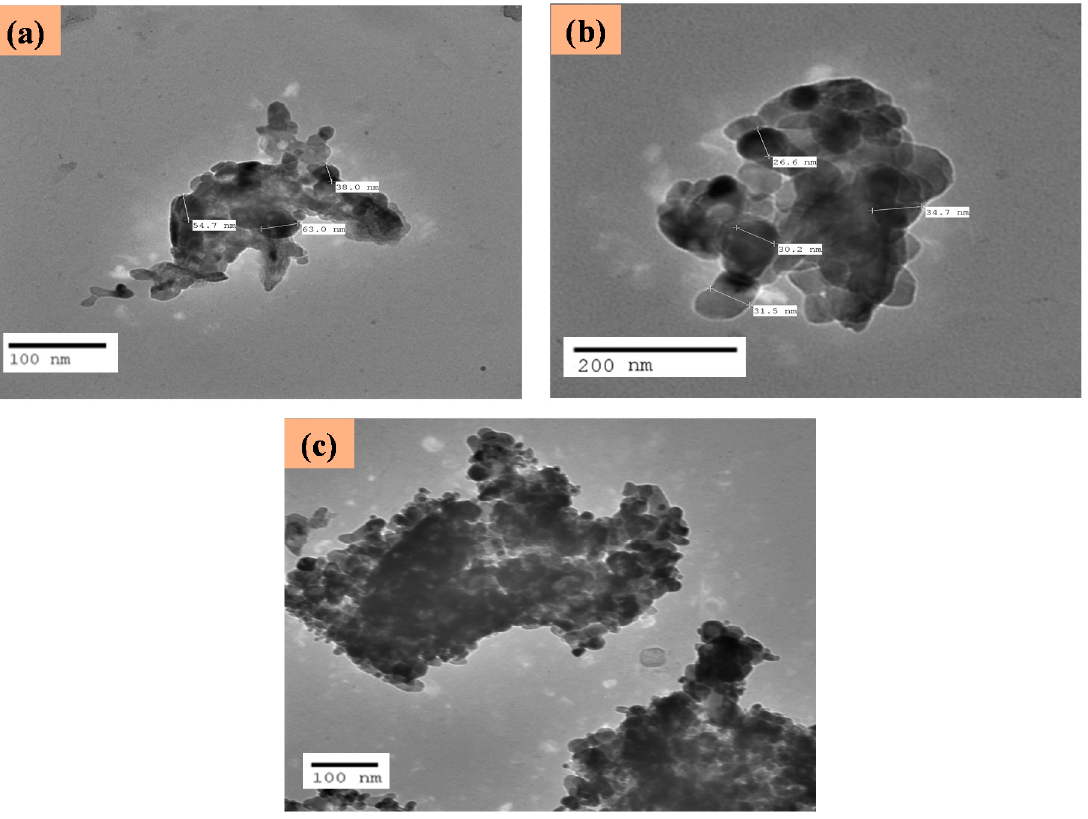
Figure 8. TEM micrographs of AL7075/4 wt.% TiC composite powder milled for: ( a ) 3 h, ( b ) 5 h, and ( c ) 7 h.